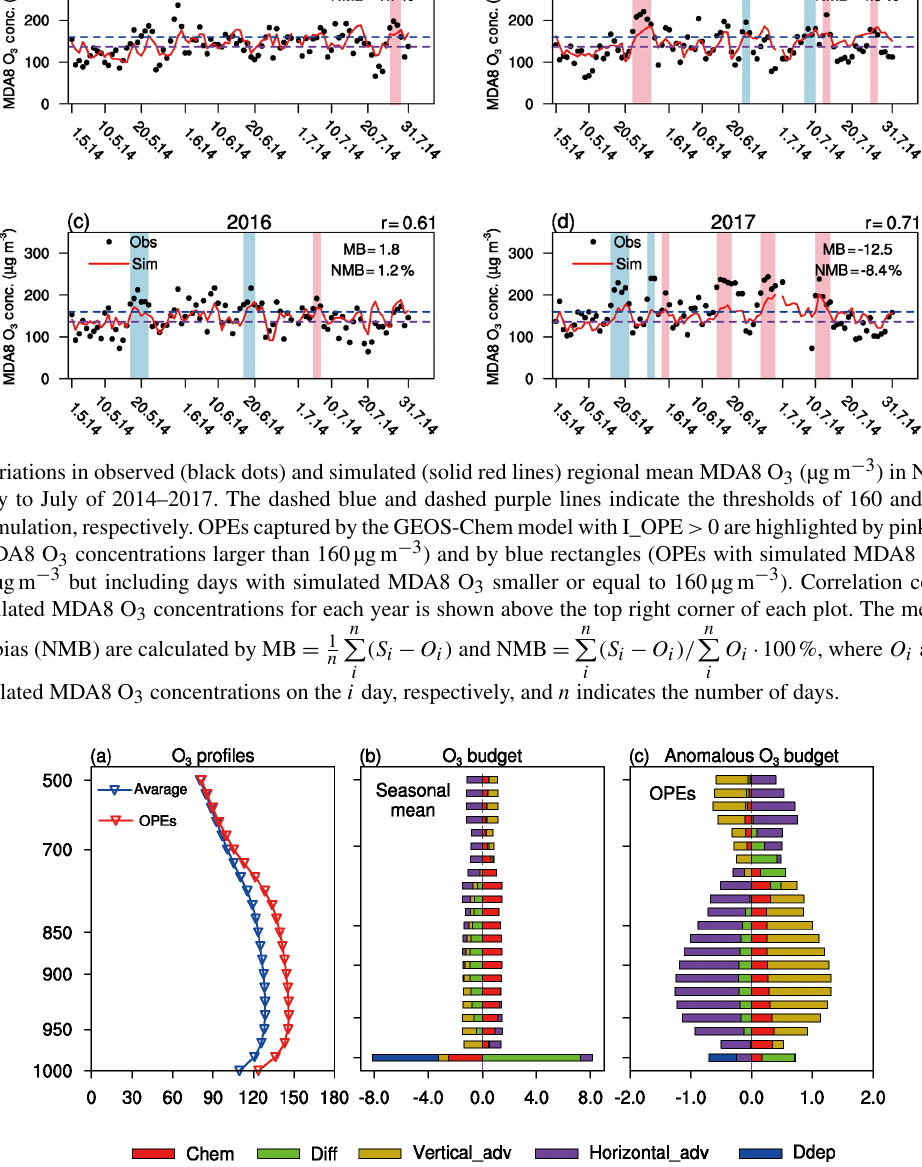
Figure 8. (a) Vertical profile of simulated daily O 3 concentrations (µgm − 3 ) averaged over the months of May to July in 2014–2017 (blue line and triangle) as well as those composited over the 15 simulated OPEs with I_OPE > 0 (red line and triangle) in North China. (b) Vertical profile of net change in O 3 mass (GgO 3 d − 1 ) over North China for each process that is averaged over all days in the months of May to July of 2014–2017. (c) Anomalous vertical profile of each process during the 15 OPEs relative to the mean value of the months of May to July of 2014–2017. The vertical axis is the same for all the panels with a unit of